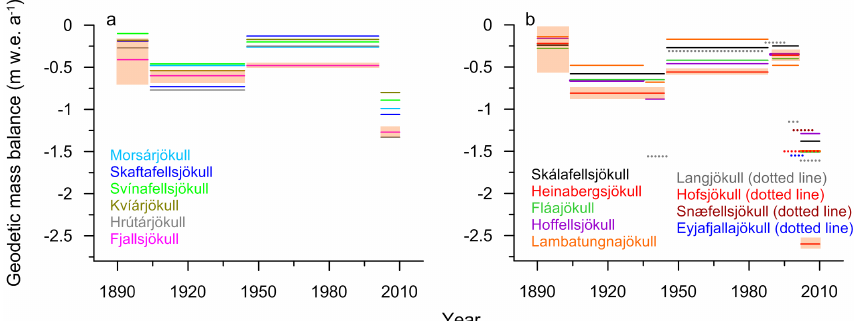
Figure 11. Geodetic mass balance rates during different time periods of the last 120 years. (a) The outlet glaciers of Öræfajökull and Morsárjökull. (b) The eastern outlet glaciers. For comparison, the geodetic mass balance of Langjökull (Pálsson et al., 2012), Eyjafjallajökull 1998–2004 (Guðmundsson et al., 2011), Snæfellsjökull 1999–2008 (Jóhannesson et al., 2011), and Hofsjökull 1995–2010 (Jóhannesson et al., 2013) is presented with dotted lines in (b) . The two latest time periods of Langjökull (1997–2002 and 2002–2010) are based on surface mass balance measurements (data base Glaciological group Institute of Earth Sciences, University of Iceland). For error estimates of the geodetic mass balance see Table 5, only the error bars for Fjallsjökull and Heinabergsjökull are shown